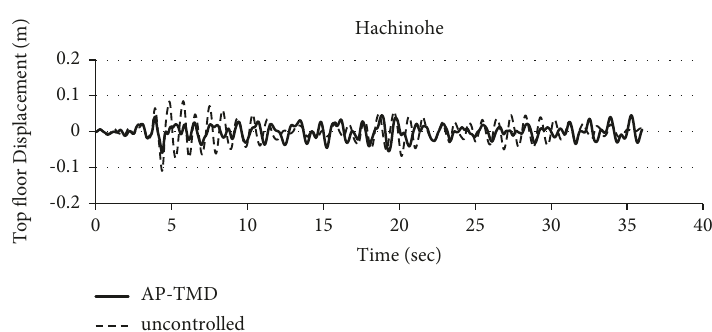
Figure 16: Top floor displacement of structure under